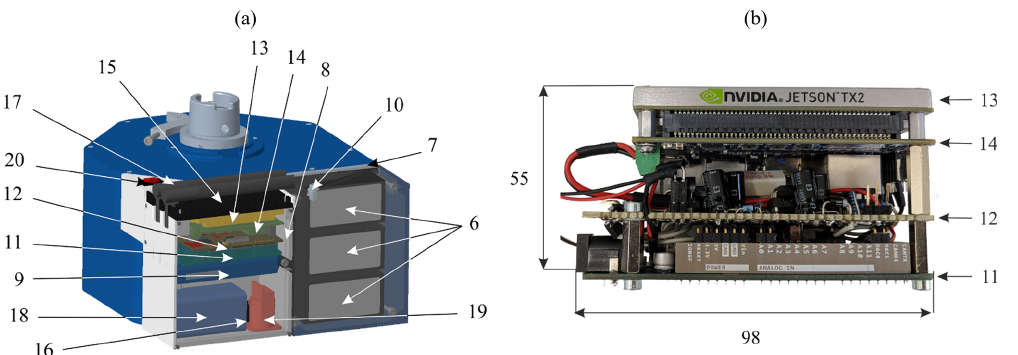
Figure 3. (a) CAD model of the integrated control system including a battery powered (18) embedded architecture (11–14) and a fiber switch (8) toggling a three-laser system (6). (b) Detailed photograph of the embedded